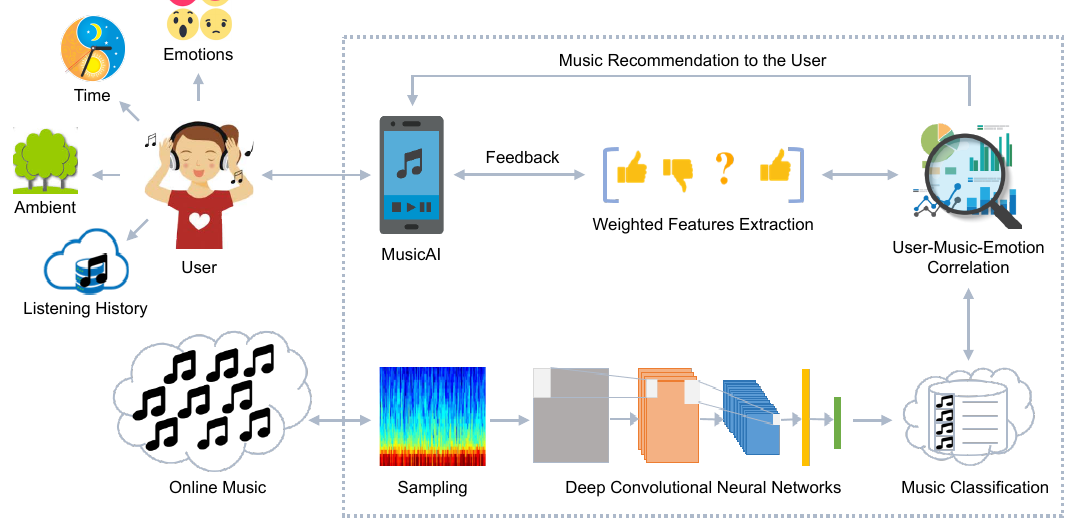
Figure 1. The system architecture of the EPMRS (emotion-aware personalized music recommendation